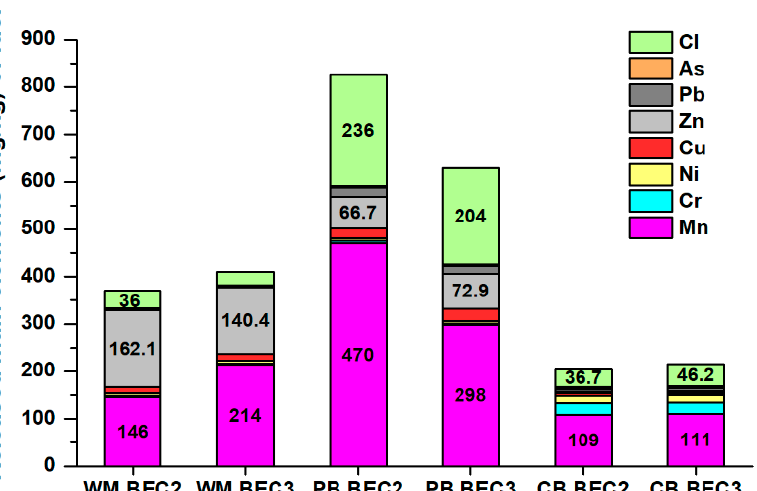
Figure 5. Trace elements (As, Cr, Cu, Mn, Ni, Pb, and Zn) with chlorine released from the burning of 1 kg of fuel.